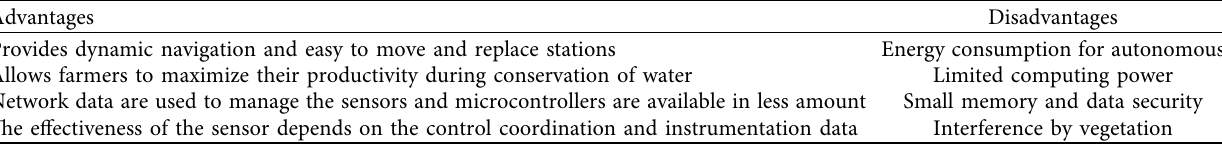
Table 6: Advantages and disadvantages of wireless sensor